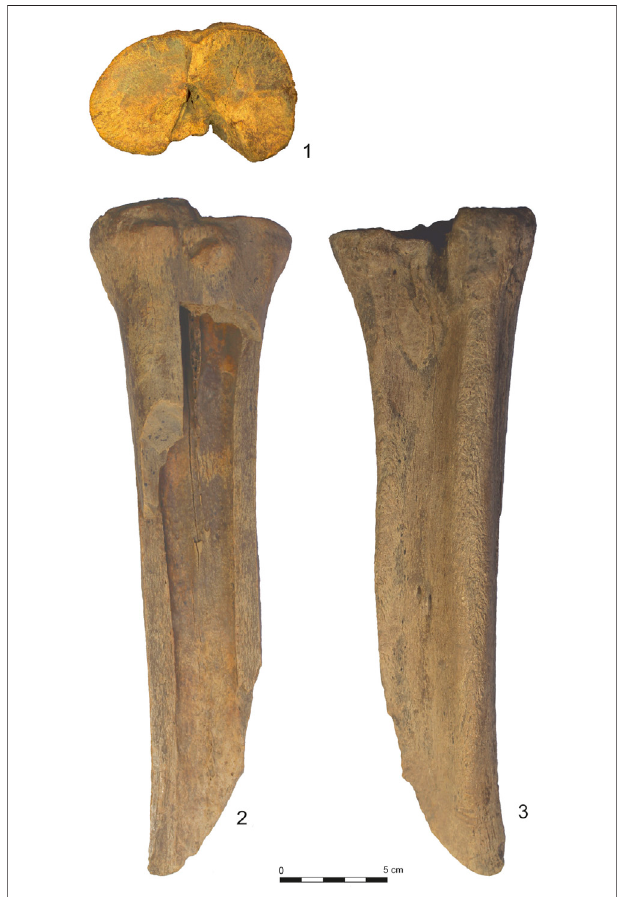
FIGURE 2 | Proximal metacarpal (MC III + IV) fragment of Camelus knoblochi from Tsagaan Agui Cave, Mongolia: 1 - proximal view, 2 - dorsal view, 3 - plantar